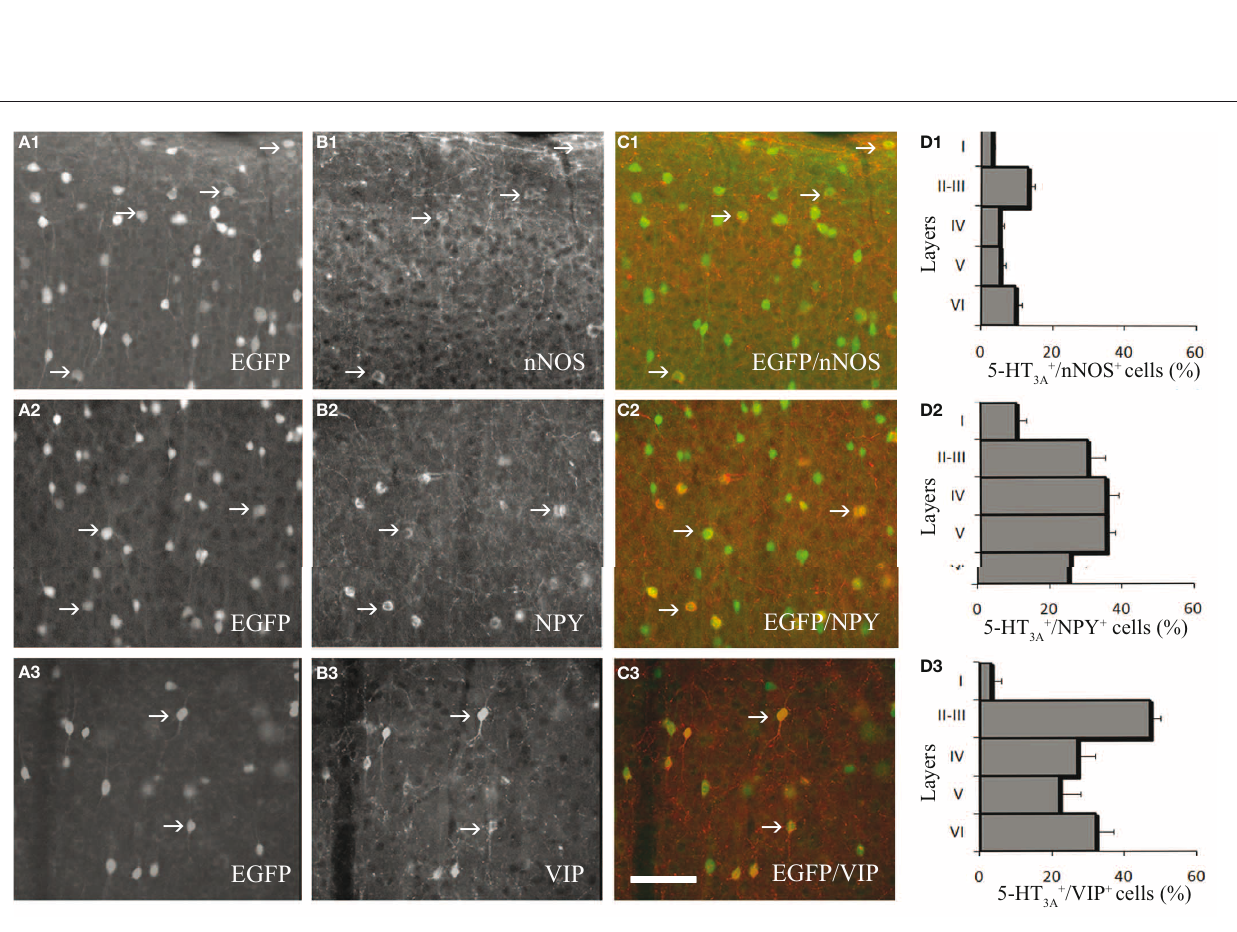
Overlays showing the colocalization of GFP withnNOS (C1), NPY(C2), or VIP (C3). (D1–3) , Density of 5-HT 3A -expressing cells colocalized with nNOS (D1), NPY(D2), or VIP(D3) in the different layers of the somatosensory cortex. Examples of co-labeled neurons are pointed by arrows. Scalebar: 65 μ